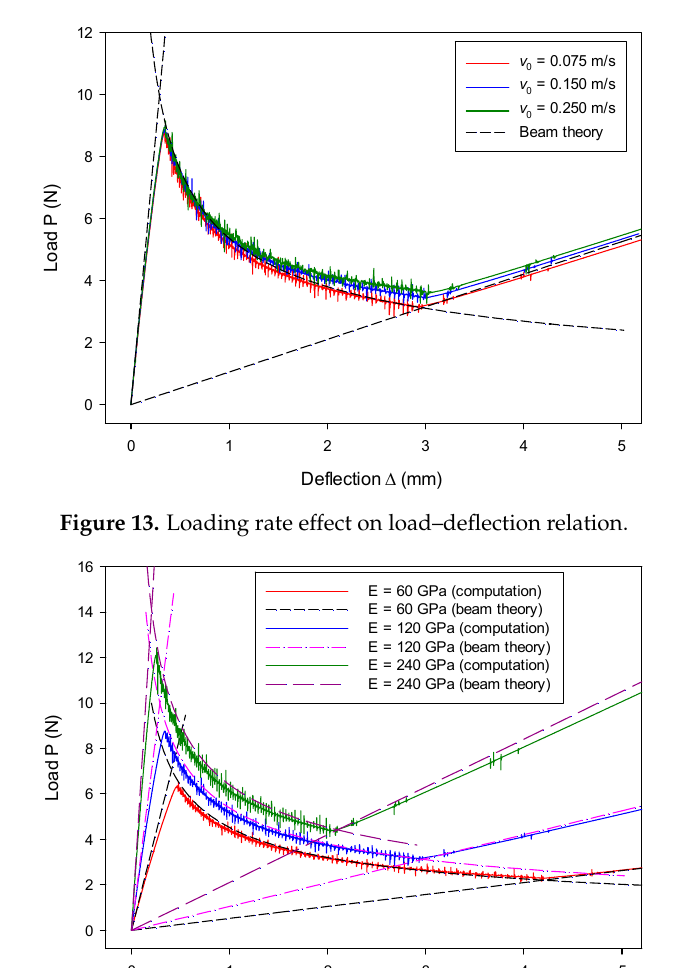
Figure 13. Loading rate effect on load–deflection relation.